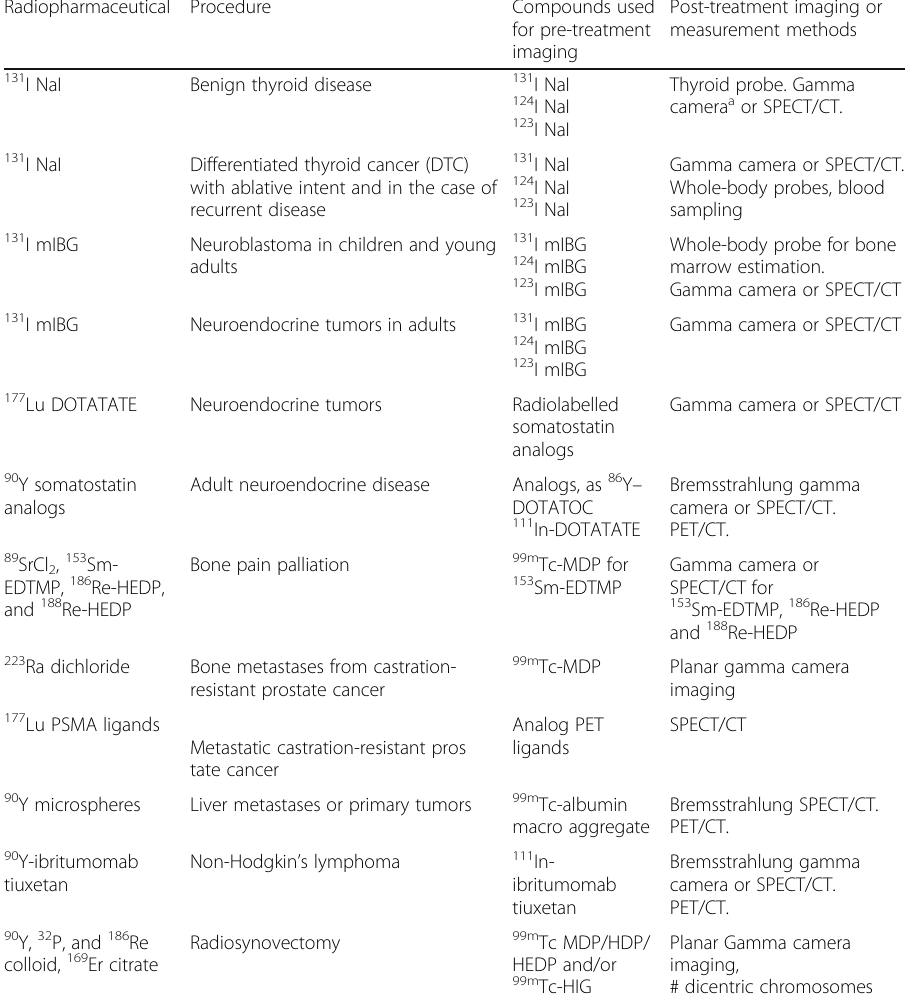
Table 1 Molecular radiotherapies and possibilities for dosimetric treatment planning identified in the